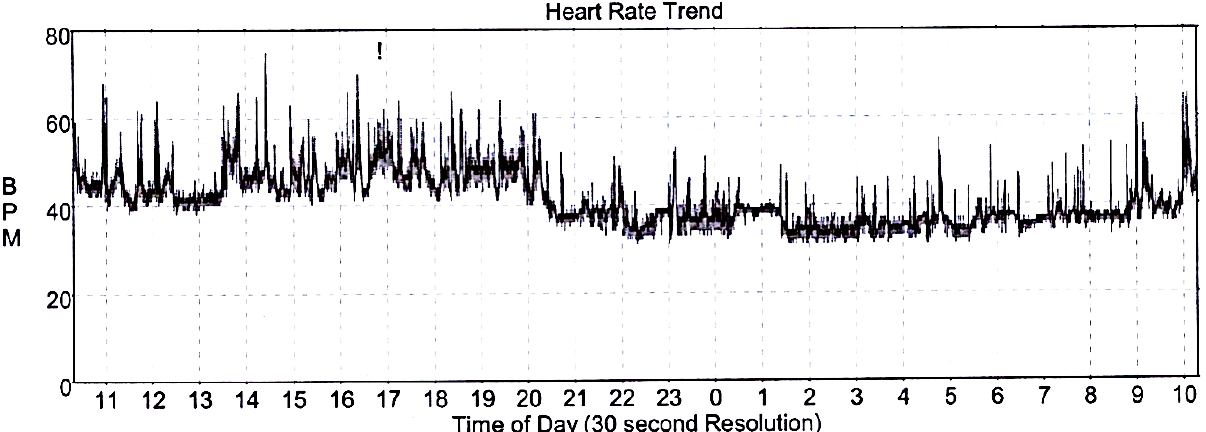
Figure 2. Patient’s ECG 24 h Holter with a mean heart rate of 41 beats per minute and the lowest value of 31 beats per minute.